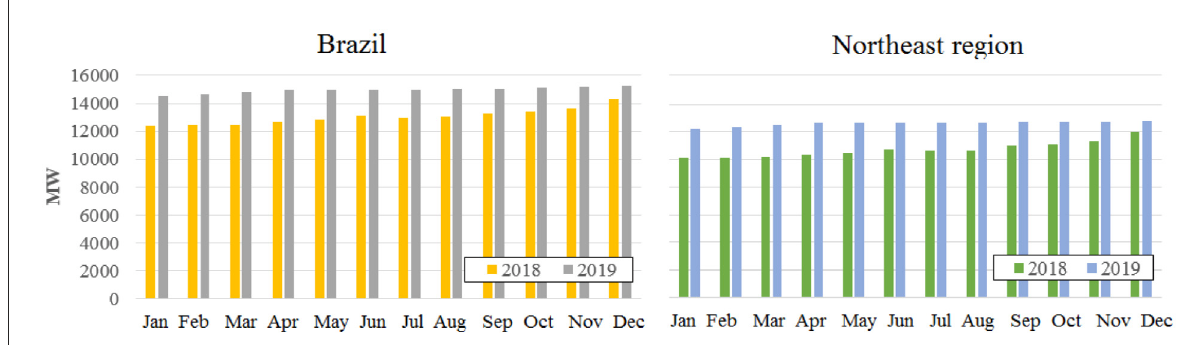
FIGURE3 Installed capacity (MW) of wind power generation in Brazil and the Northeast region. Source: National Electric System Operator